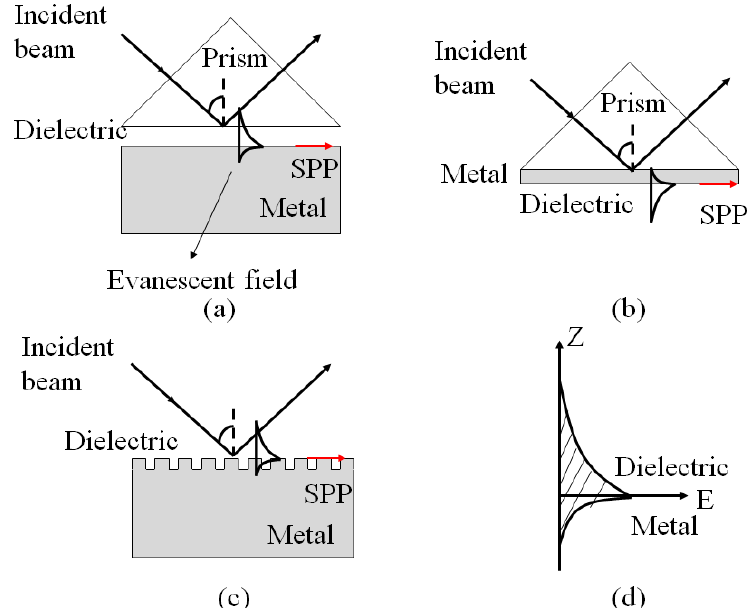
Figure 9. Surface plasmon resonance: ( a ) Otto configuration, ( b )